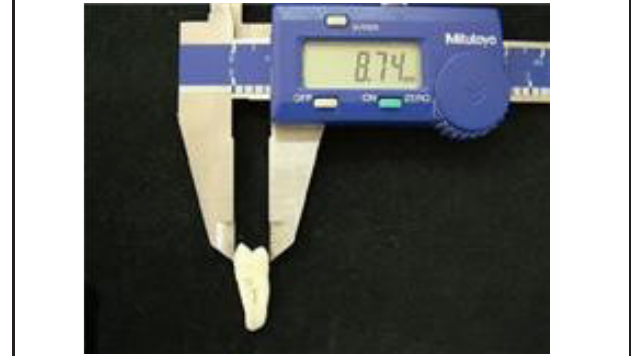
Fig. 2 – Measure of the tooth crown buccolingual dimension.